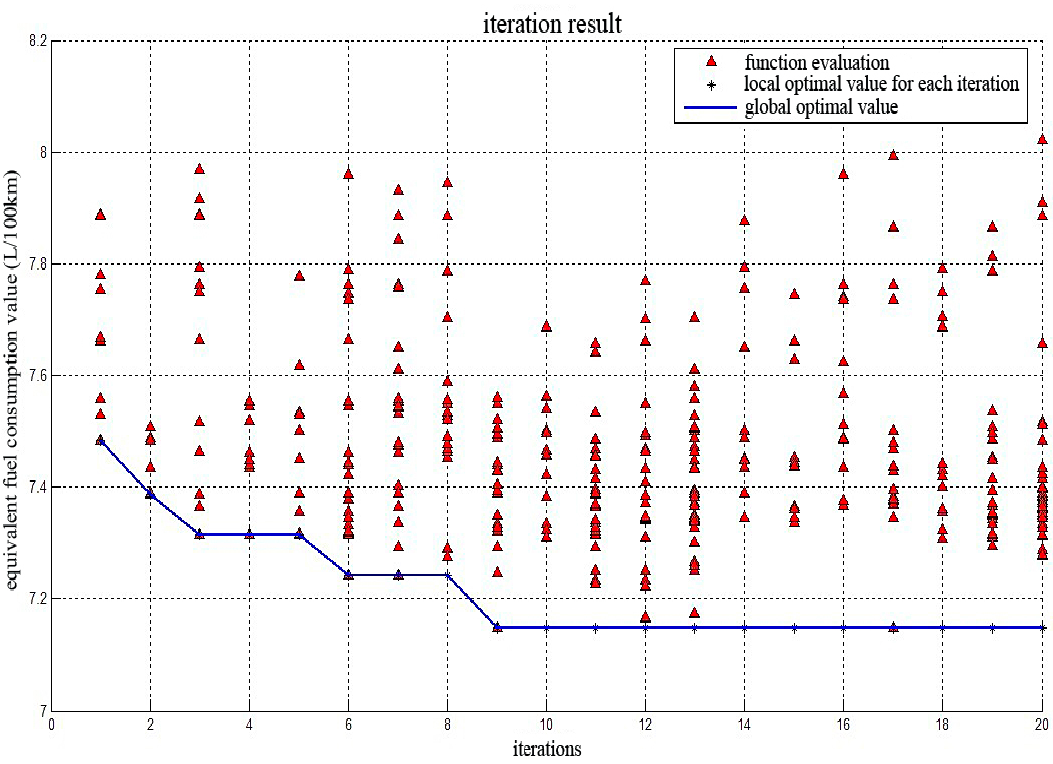
Figure 20. Equivalent fuel consumption of different iterations using DIRECT algorithm.